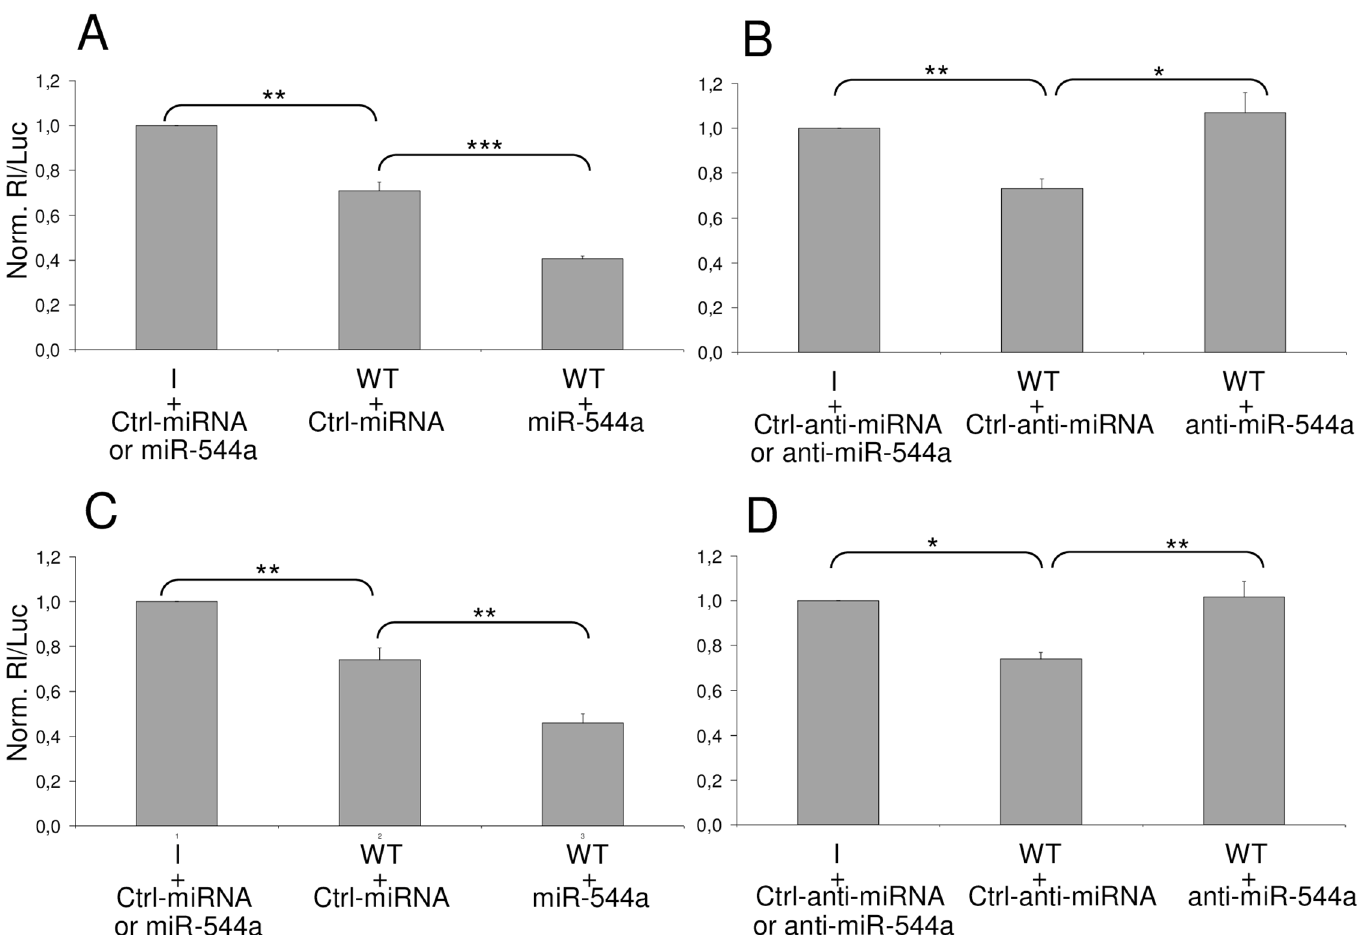
Fig 3. Interfering activity of miR-544a in HCC cell lines. HuH-7 and HepG2 cells were transfected with the luciferase-based reporter plasmid psiCheck-2 containing the SELK target sequence for miR-544a (WT) or a control DNA with inverted sequence (I), along with 50 nM miR-544a mimic (miR-544a, A and B) or 50 nM miR-544a inhibitor (anti-miR-544a, C and D). Ctrl-miRNA and Ctrl-anti-miRNA are their relative unrelated molecules used as negative controls. Significant p-values evaluated by Student ’ s t-test were indicated with * , ** and *** when P < 0.05, or < 0.01 or <